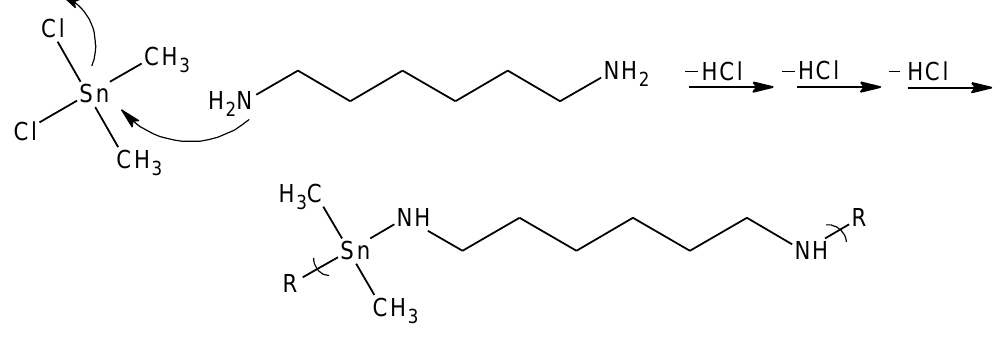
Figure 14. General reaction scheme for the reaction between dimethyltin dichloride and 1.6-hexamine to form a dimethyltin polyamine.